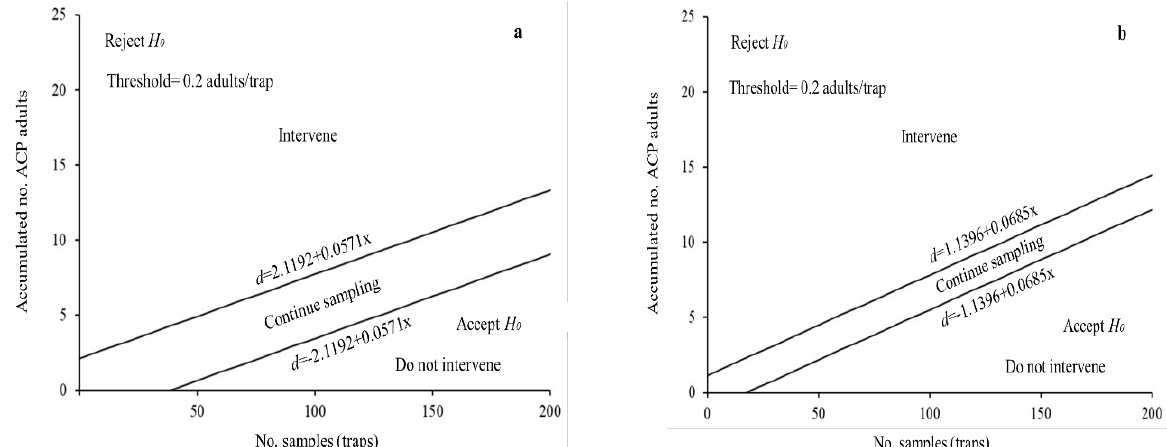
Figure 2. Decision stop lines of the SPRT sequential sampling plans for the Asian citrus psyllid. Threshold= 0.2 ACP adults/trap. ( a ) Veracruz state. ( b ) Michoacán state.